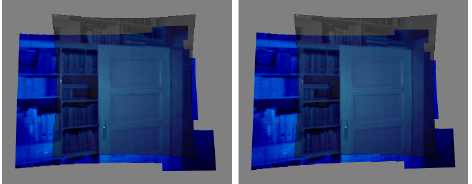
Figure 13: Frontal view onto the infrared-textured point cloud before and after removing unreliable points.